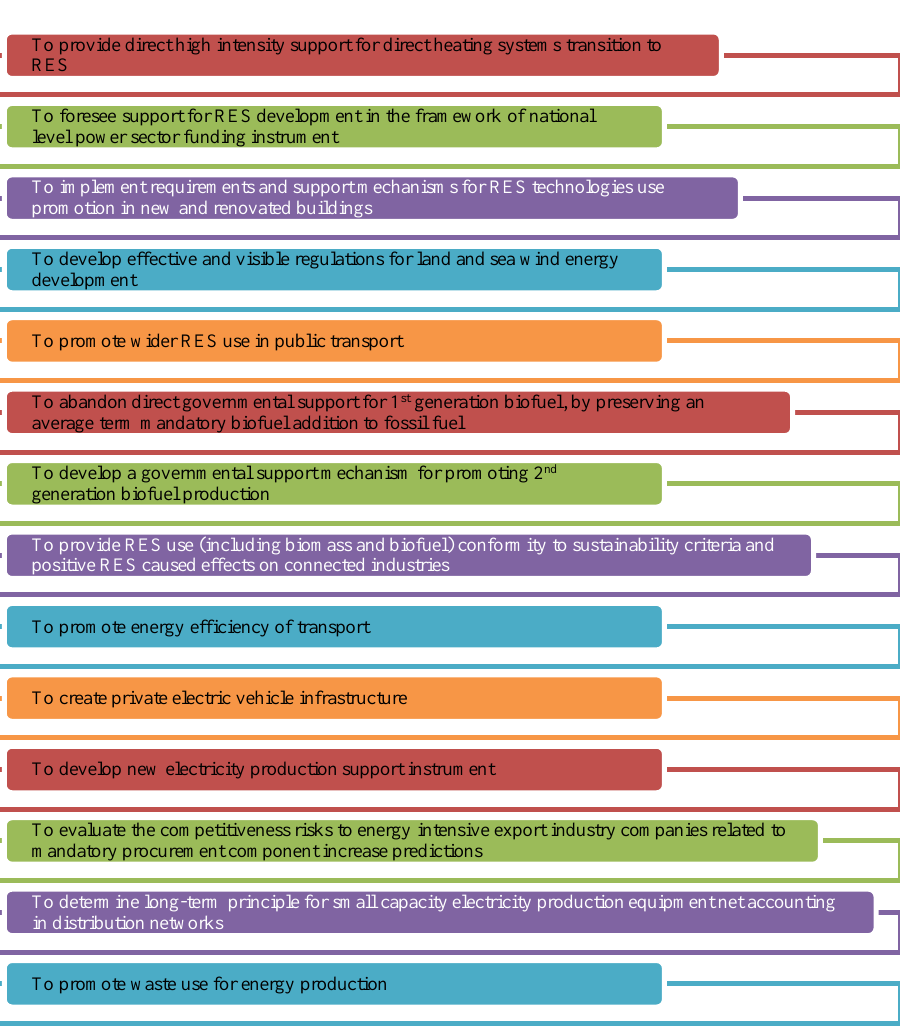
Fig. 8. Renewable energy sources use promotion